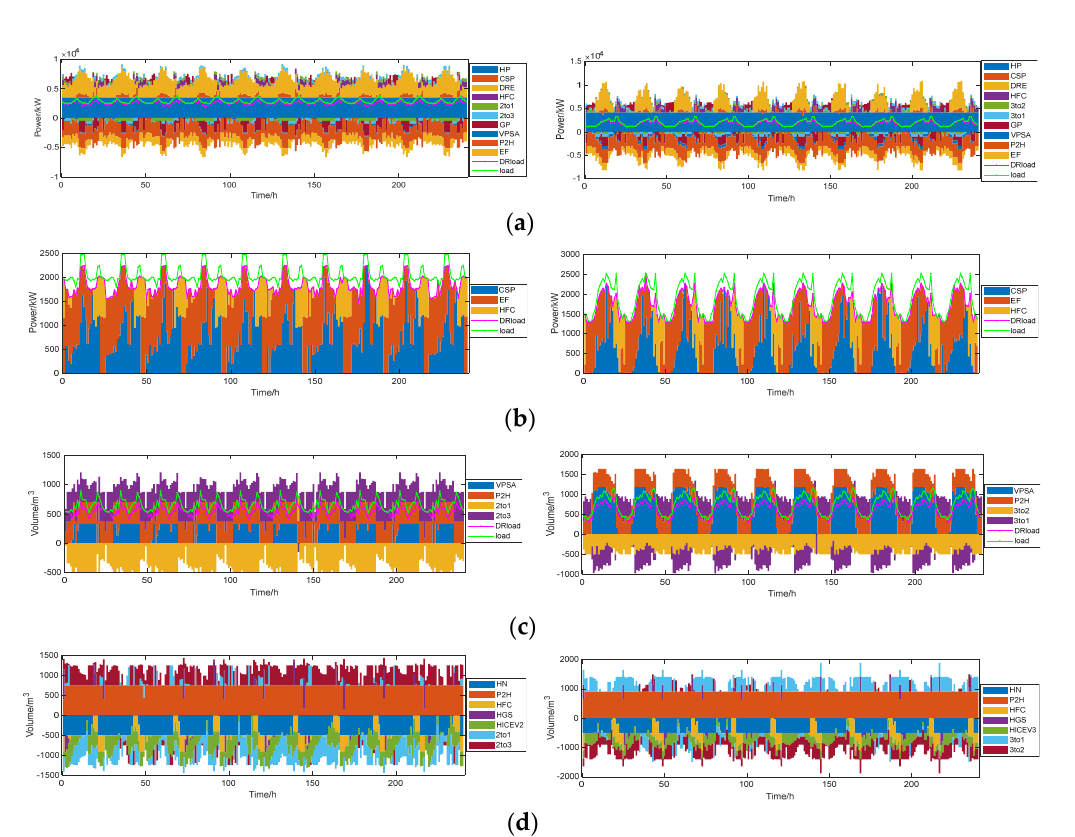
Figure A1. IES2 and IES3 energy balance. ( a ) IES2 and IES3 electric power balance. ( b ) IES2 and IES3 heat power balance. ( c ) IES2 and IES3 oxygen balance. ( d ) IES2 and IES3 hydrogen balance.